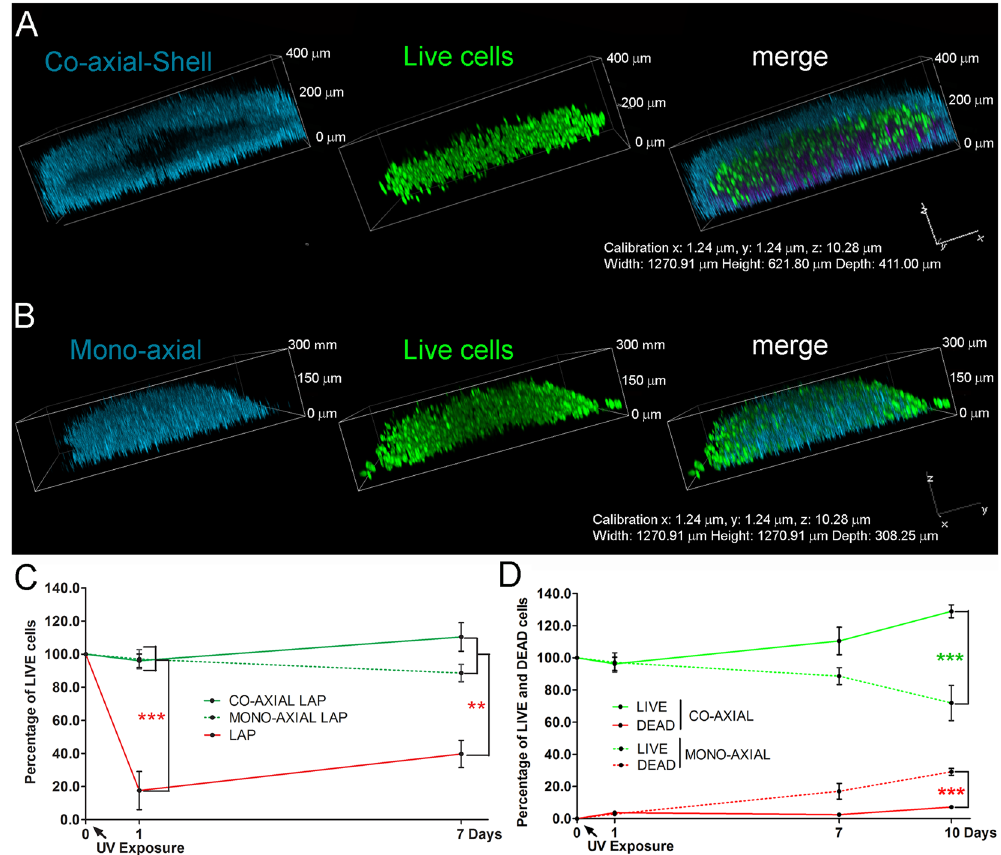
Figure 5. The co-axial printing produces 3D printed samples with high cell viability. ( A , B ) Representative 3D rendered confocal images of ADSCs Core/Shell (co-axial) and mono-axial bioprinted samples stained with Calcein-AM (live cells, green channel). The samples were labeled with fluorescent beads for identification of the Shell (GelMa/HAMa plus LAP 0.1%, cyan channel). Mono-axial samples were also labelled with fluorescent beads for analysis (GelMa/HAMa plus LAP 0.1% and ADSCs, cyan channel). z -stacks were acquired every 10 μ m and 3D rendering was performed with NIS elements software using the Alpha - blending algorithm. Images show representative 3D rendered of single and superimposed (merge) cyan and green channels of confocal single 2D z -stacks. ( C ) The graph shows the quantification of Calcein-AM stained ADSCs to measure cytotoxicity over time in culture right after UV irradiation in co-axial (Core/Shell) and mono-axial 3D printed samples, and in 2D monolayer. The co-axial approach demonstrates higher cell viability and proliferation compared to mono-axial samples and 2D at 7 days post irradiation exposure. Error bars represent standard error of the mean between three replicates. Statistical significance (p < 0.05) was determined by One way Anova test with Dennett’s correction. ( D ) The graph shows the quantification of live and dead staining performed with Calcein-AM (live cells, green lines) and SYTOX (dead cells, red lines) to measure cytotoxicity over time in culture in both Core/Shell (co-axial, solid line) printed and mono-axial (dotted line) samples. The Core/Shell approach demonstrates significantly higher cell viability and proliferation compared to mono-axial samples at 10 days. Error bars represent standard error of the mean between three replicates. Statistical significance (p < 0.05) was determined by unpaired t